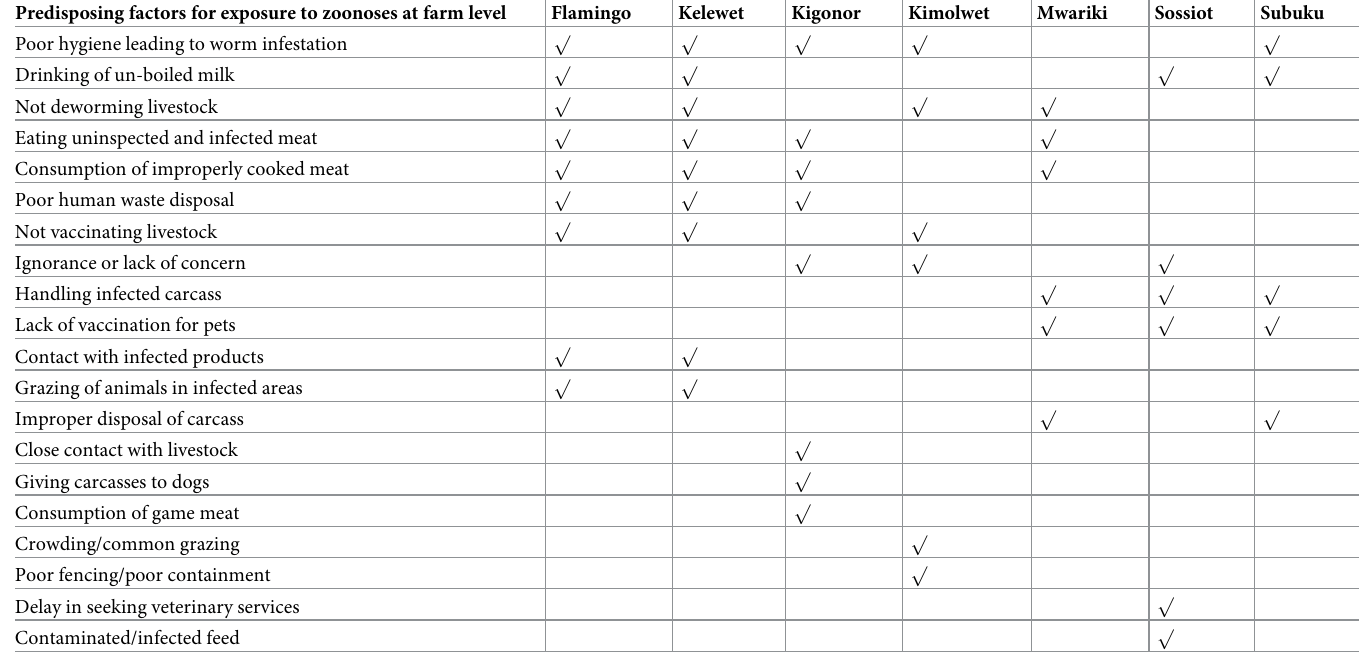
Table 3. Farm-level practices that expose people to infection as identified by focus group participants, Nakuru, Kenya, 2020. Predisposing factors for exposure to zoonoses at farm level